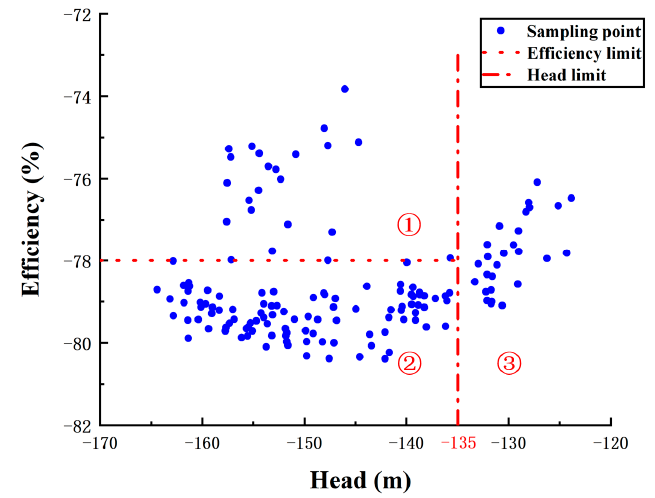
Figure 7. Sample data screening diagram .